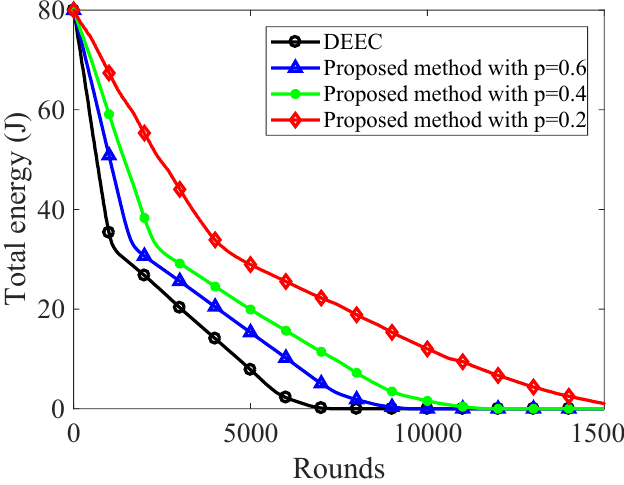
Figure 7. Total energy over